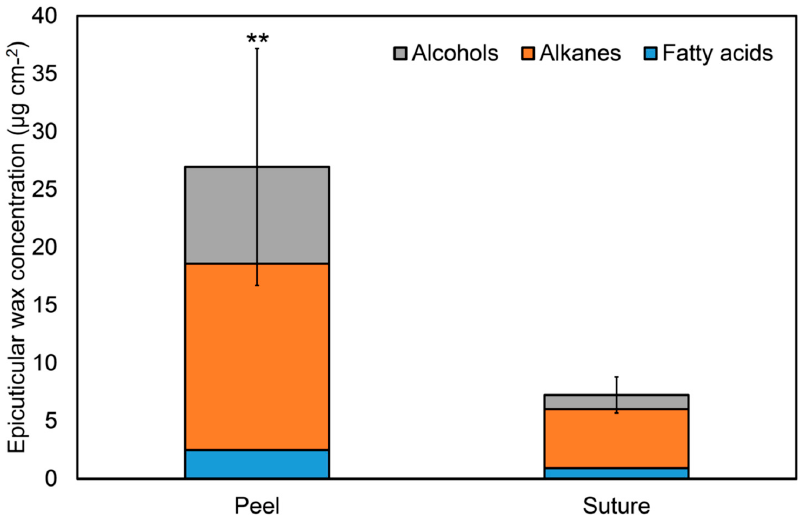
Figure 5. Comparison of epicuticular wax on oriental melon peel and sutures. Data are presented as mean ± SD of three replicates. Asterisks (**) indicate significant difference of total epicuticular wax between peel and suture by Student’s t-test with p < 0.01.